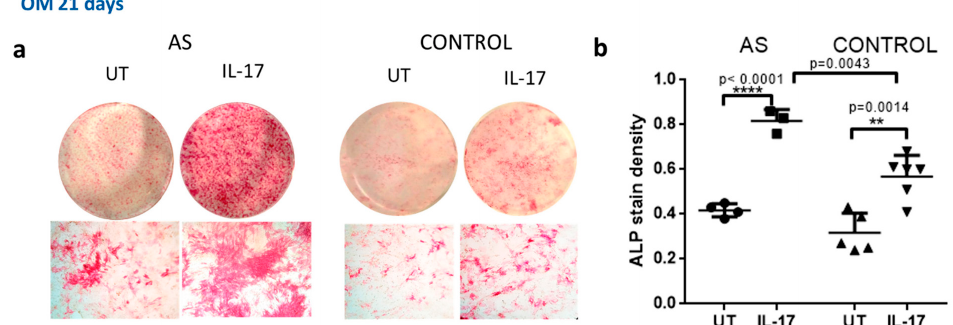
Figure 4. IL-17 enhances ALP activity. MSCs from the control group and AS group were cultured in osteogenic medium (OM) for 21 days in the presence (IL-17) or absence (UT) of 50 ng/mL IL-17, and ALP activity staining was performed. ( a ) ALP-stained representative photographs from whole culture dishes (top row) and microscopic fields (bottom row). ( b ) Quantification analysis of ALP stain density. Mean ± SD. ** = p < 0.01; **** = p < 0.0001.